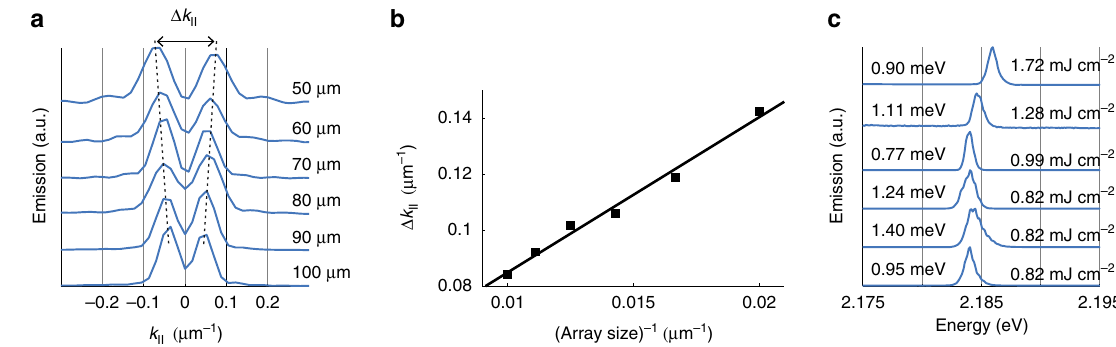
Figure 5 | Dependence of the k -space beating pattern on the array size. ( a ) Normalized constant energy crosscut of the dark mode lasing peak as a function of in-plane k -vector for different array sizes. ( b ) The separation of the peaks in a as a function of 1/(array size). The separation of the lasing peaks for 100 and 50 m m array corresponds to angular separation of 0.44 (cid:2) and 0.74 (cid:2) , respectively. Divergence of individual peaks vary between 0.29 (cid:2) and 0.44 (cid:2) . ( c ) The lasing spectra for each array size integrated over the double peak from k ¼ (cid:3) 0.2 to k ¼ 0.2 m m (cid:3) 1 . The threshold fluence P th depends on the array size. The linewidth of the lasing peak is denoted on the left and P th on the Measurement setup . The image of the back focal plane of the objective was focused to the entrance slit of the spectrometer. Thus the transmitted (or emitted) light from the sample into a given angle is focused into a single position on the entrance slit. One axis of the two-dimensional (2D) CCD camera of the spectro- meter can then be used to resolve the angle of the transmitted/emitted light, while the other axis is used to resolve the wavelength. The E ( k ) dispersions were subsequently calculated from the angle and wavelength resolved spectra as E ¼ hc / l and k jj ¼ k 0 sin ð y Þ . Here k 0 ¼ 2 p / l and y is the angle with respect to sample normal. The real space images were obtained by focusing the image plane of the same sample onto a separate 2-D CCD camera. For lasing measurements, the gain medium was pumped with a femtosecond laser (45 (cid:2) incident angle, 500nm centre wavelength, 100fs pulse width, 1kHz repetition rate). The gain medium consisted of 31mM Rhodamine 6G in Benzyl Alcohol.